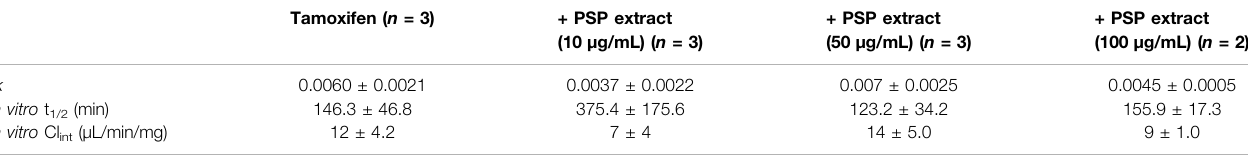
TABLE 4 | In vitro Cl int of tamoxifen (0.5 mM dissolved in 25% acetonitrile) with or without PSP extract in female rat hepatic